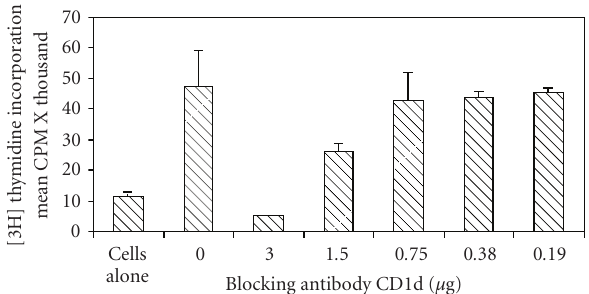
Figure 7: Demonstration of CD1d dependence of iNKT cells. Proliferation of line 1F1.1 in response to thyroglobulin was assessed after blocking CD1d. Di ff erent concentrations of mouse CD1d mAb were used starting from 0.0–3.0 μ g/well. Concentration 0 represents no blocking. Proliferation in response to thyroglobulin was abrogated after CD1d blocking showing that iNKT cells recognized thyroglobulin in a CD1d-dependent manner. [3H] thymidine incorporation was measured as an indicator of prolifer- ative response. Data represents mean CPM of triplicate wells from each